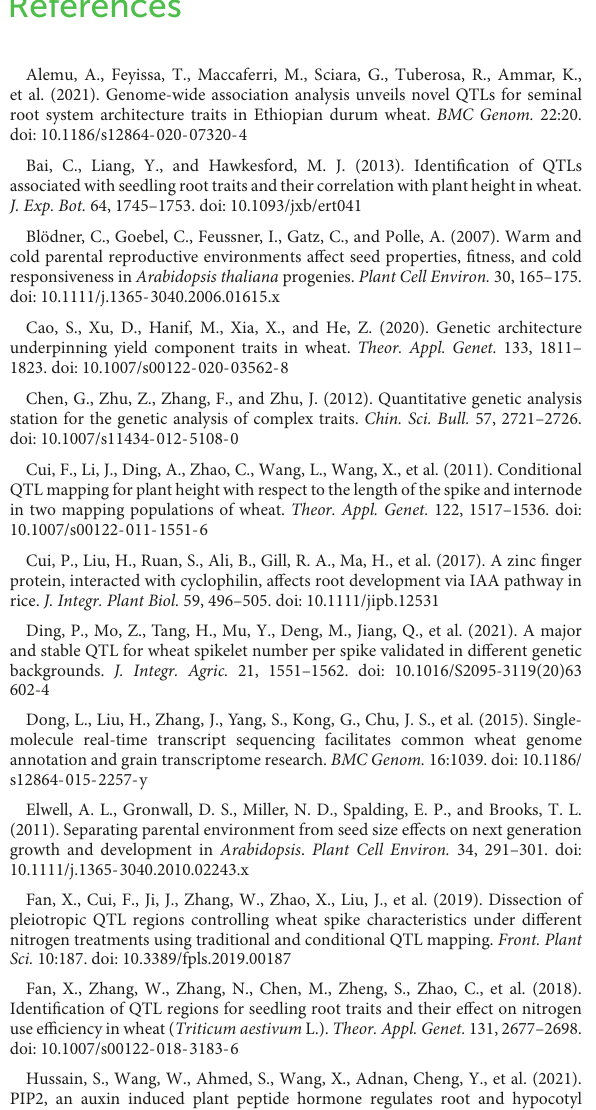
triangle represents lines with heterozygous alleles. ∗∗ Means significant difference at 0.01 probability level. SUPPLEMENTARYFIGURE4 Expression patterns of TraesCS4D03G0059800 (A) , TraesCS4D03G0057800 (B) , TraesCS4D03G0064000 (C) , and TraesCS4D03G0064400 (D) in different tissues of wheat. SUPPLEMENTARYTABLE1 Information of kompetitive allele-specific PCR (KASP) used in this study. SUPPLEMENTARYTABLE2 Correlation coefficients of five independent tests for root system architecture(RSA)-related traits.